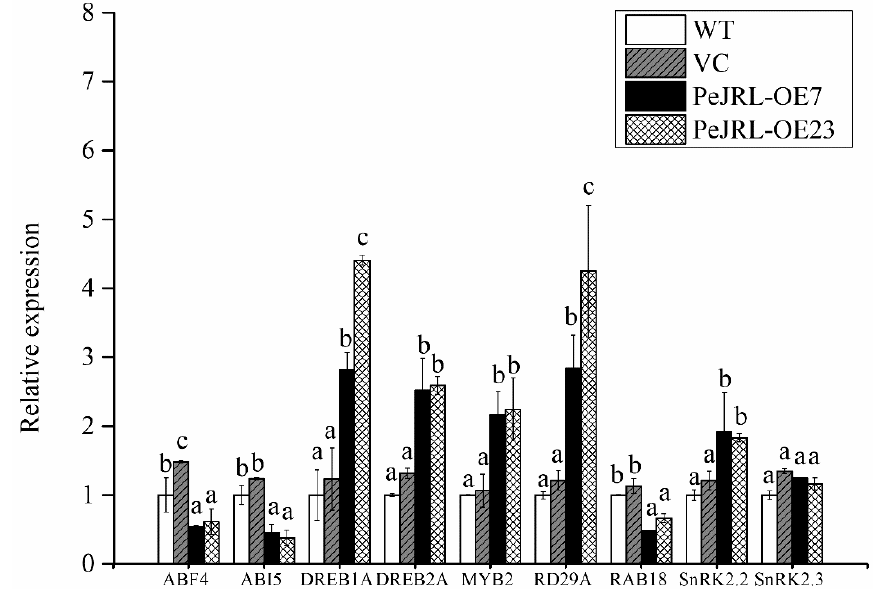
Figure 13. Expression level of ABA-mediated salt stress responsive genes in wild-type (WT) Arabidopsis, vector control (VC), and PeJRL -transgenic lines (OE7 and OE23) under salt stress. Five-day-old seedlings were transferred to MS medium containing 75 mM NaCl for 10 days. Transcription of ABA-mediated salt stress responsive genes was detected with RT-qPCR. The Arabidopsis AtACTIN2 was used as the internal control. Primers designed to target AtACTIN2 and ABA-mediated salt stress responsive genes are shown in Supplementary Materials Table S1. For each tested gene, each column corresponds to the mean of three independent replicates and columns labelled with different letters (a–c) indicate significant differences between WT, VC, and transgenic lines at p < 0.05.